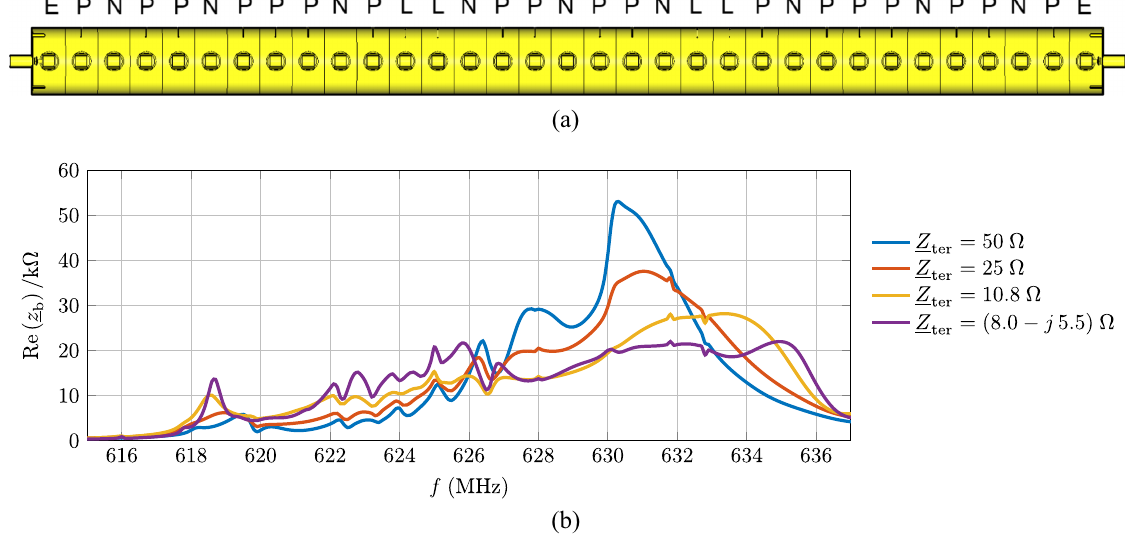
FIG. 4. (a) Cross section of the 33-cell SPS accelerating structure with 18 HOM couplers. The left and the right end cells are marked by an “ E, ” the probe-type couplers by a “ P ” , the loop-type couplers by an “ L ” , and the cells without any couplers by an “ N ” . The geometry is kindly provided by [37] and is plotted with [22]. (b) Real part of the longitudinal beam coupling impedance of the structure shown in (a) for different termination impedances Z at each of the 18 HOM ter